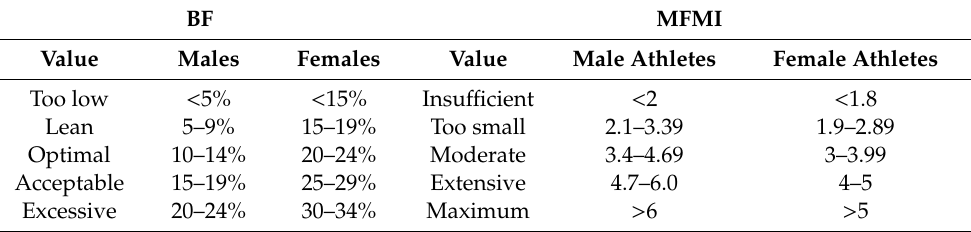
Table 1. Body fat (BF) percentage and muscle and fat mass index (MFMI) scale for athletes (by gender). BF MFMI Value Males Females Value Male Athletes Female Athletes < 5% < 15% Insu ffi